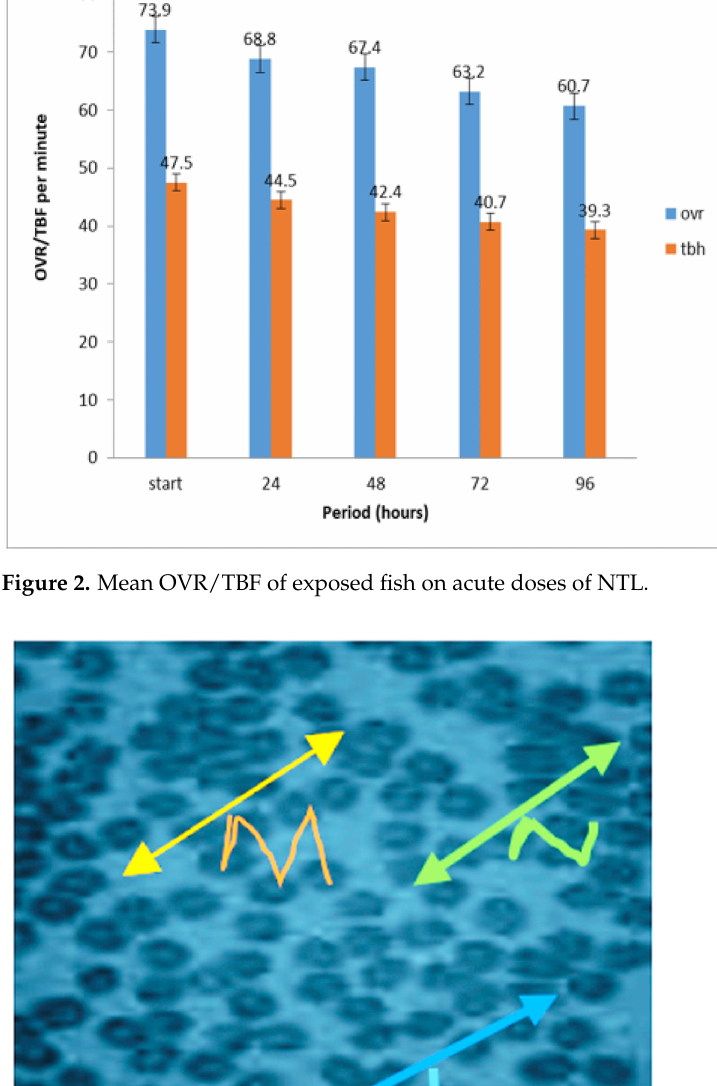
Figure 2. Mean OVR/TBF of exposed fish on acute doses of NTL.